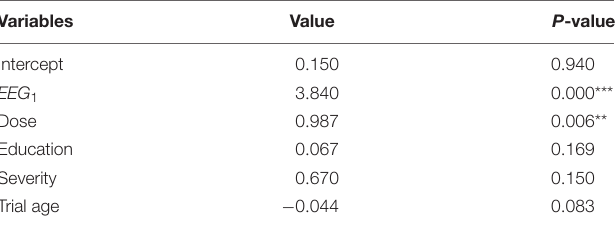
TABLE 5 | Linear mixed-effects analyses fixed effect estimates for outcome model.